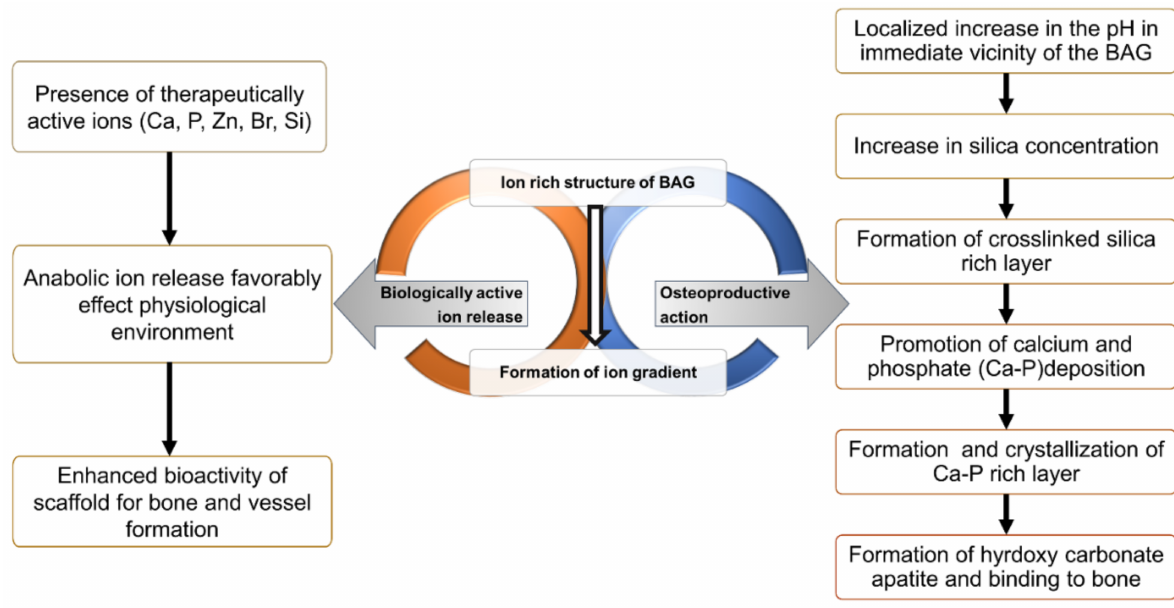
Figure 1. Two mechanisms of the action of bioactive glasses: facilitating growth on scaffolds by therapeutically active ion release [11] and promoting bone formation and adhesion